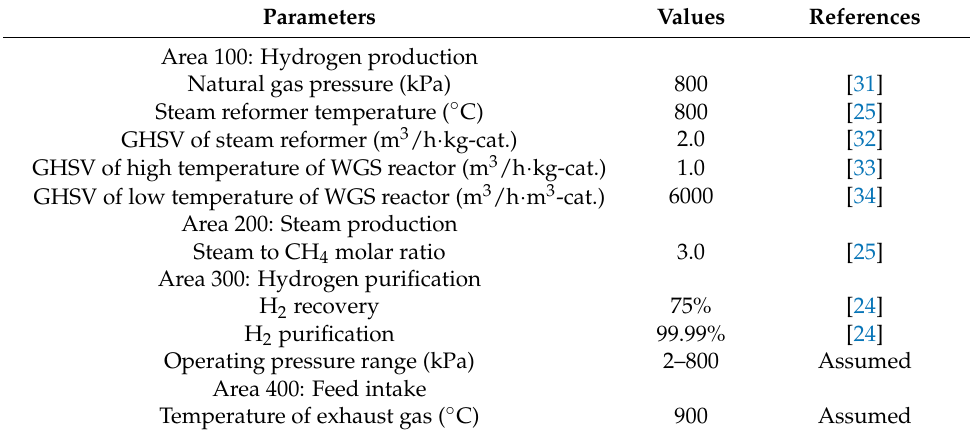
Table 1. Design and operating conditions in each process area of the developed